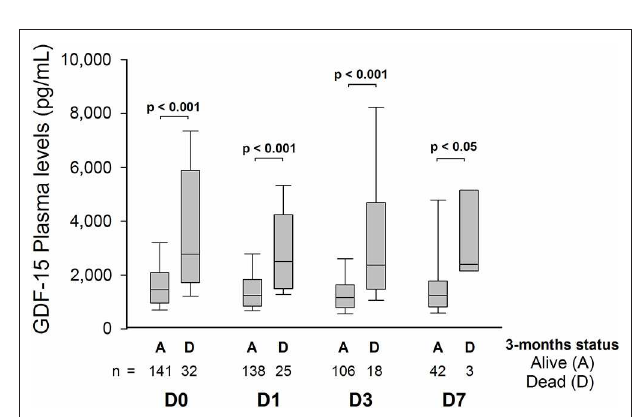
FIGURE 1 | Correlation between individual GDF-15 plasma levels at admission (D0) and either (A) age or (B) admission NIHSS score ( n = 173).